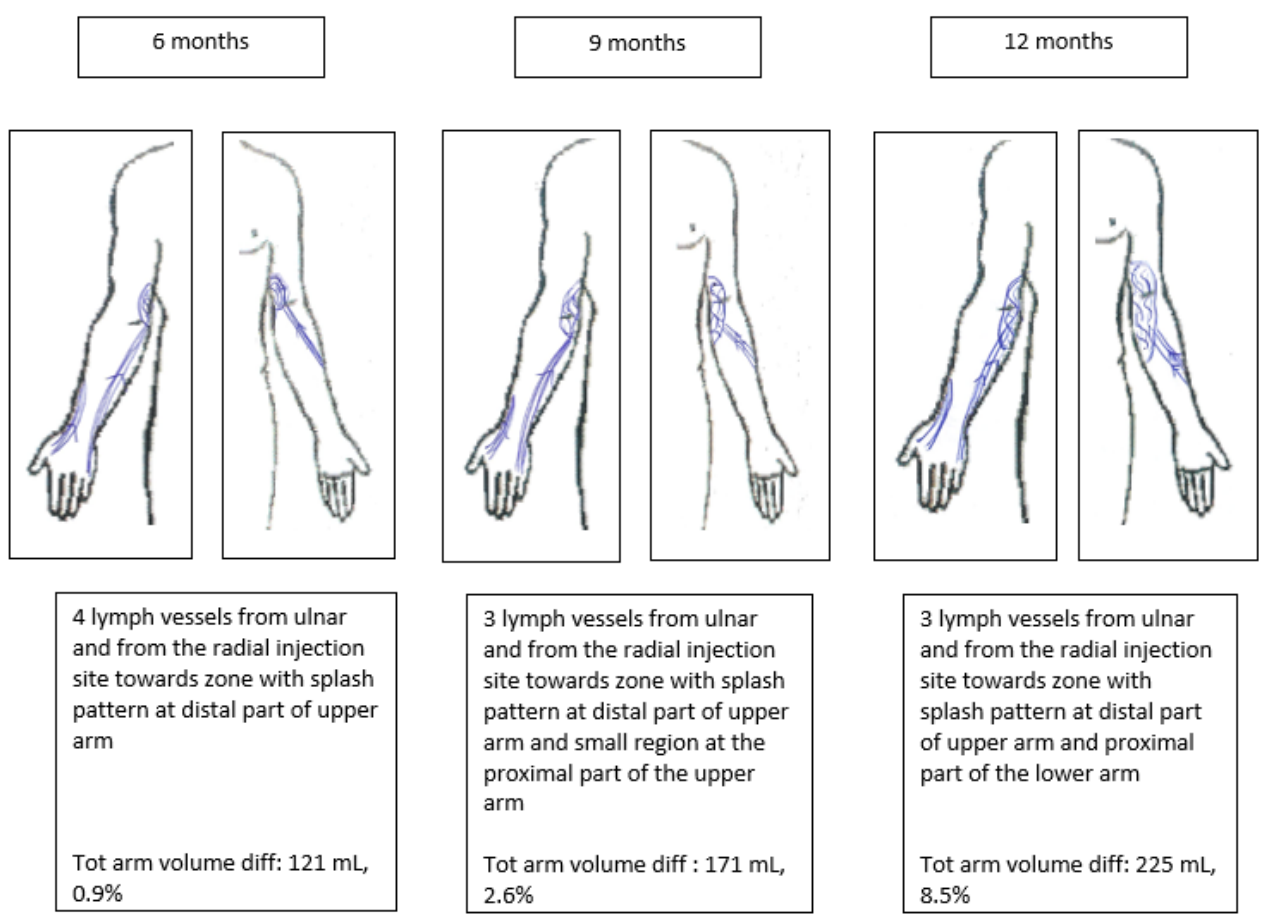
Figure 1. Lymphofluoroscopy of a patient with early disturbance 6, 9 and 12 months postoperatively and with development of lymphedema 12 months